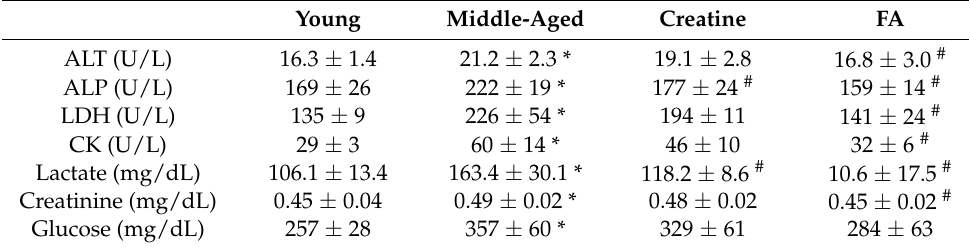
The data are expressed as the mean ± SD ( n = 5 mice per group), and p -values < 0.05 (*) as compared with the young control or p -values < 0.05 ( # ) as compared with the middle-aged control mice. ALT, alanine aminotransferase; ALP, alkaline phosphatase; LDH, lactate dehydrogenase; CK, creatine kinase.